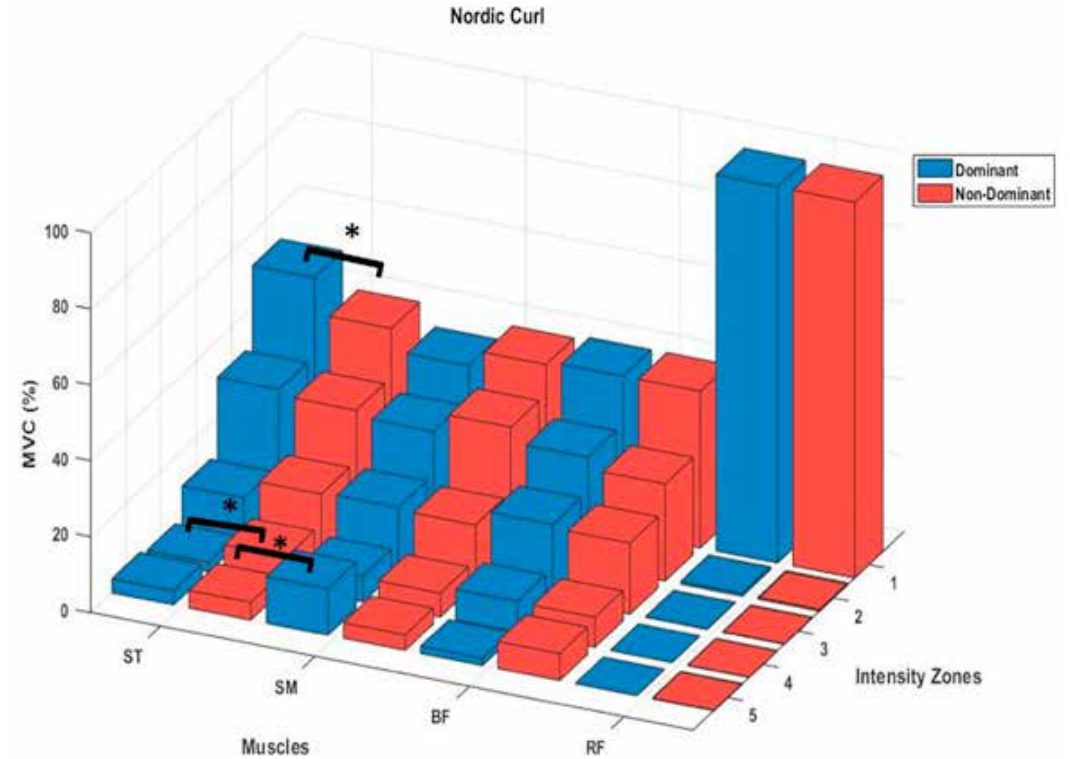
Figure 9. Comparison of activity rates of D and ND legs in the five intensity zones for the NC exercise * There was a significant difference between the D leg and ND leg (p<0.05). ST: Semitendinosus, SM: Semimembranosus, BF: Biceps femoris, RF: Rectus 294